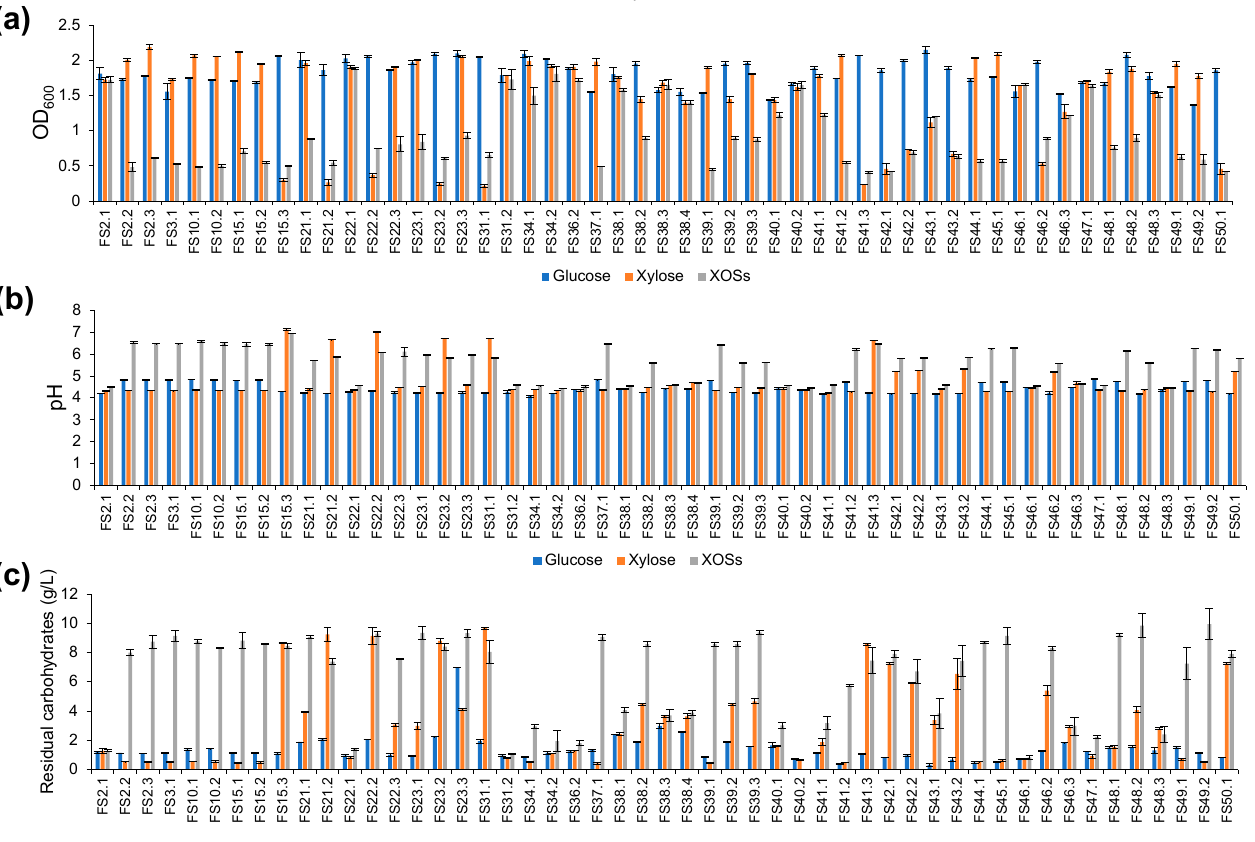
Figure 2. Effect of glucose, xylose, and XOSs on growth ( a ), change in pH ( b ), and residual carbohydrate ( c ) of the assumed XOSs-fermenting LAB. The reported pH is the final value.